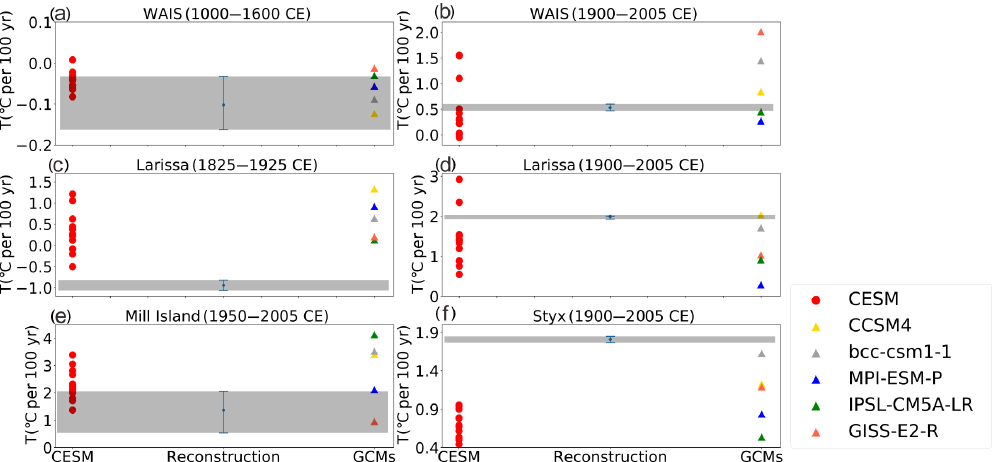
Figure 4. Linear trends for the four boreholes over different periods: (a) WAIS: 1000 to 1600CE; (b) WAIS: 1900 to 2005CE; (c) Larissa: 1825 to 1925CE; (d) Larissa: 1900 to 2005CE; (e) Mill Island: 1950 to 2005CE; and (f) Styx: 1900 to